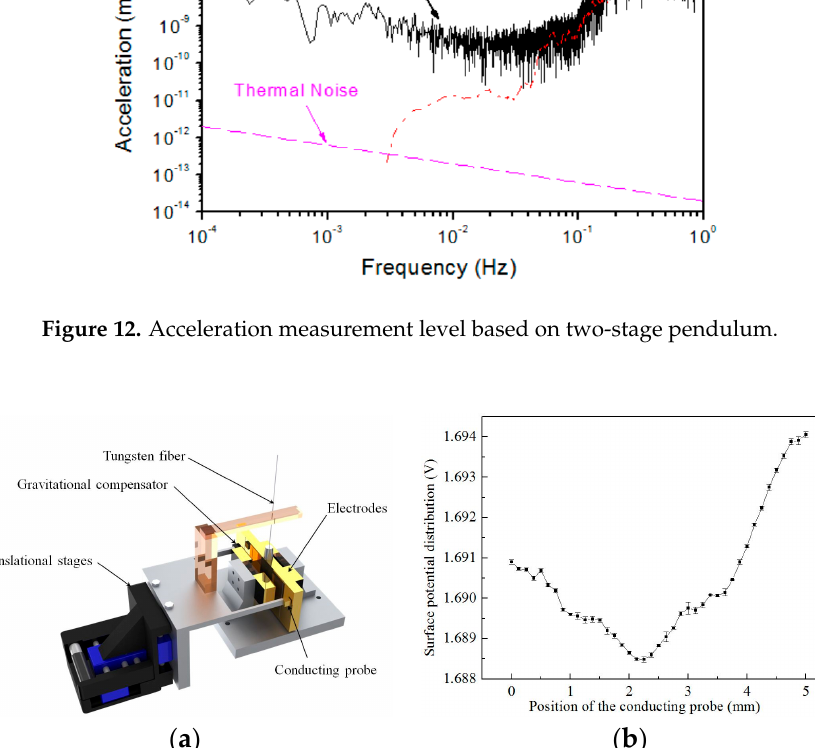
Figure 13. ( a ) Schematic of electrostatically-controlled torsion pendulum; ( b ) spatial variation of surface potential on proof mass measured by electrostatically-controlled torsion pendulum.